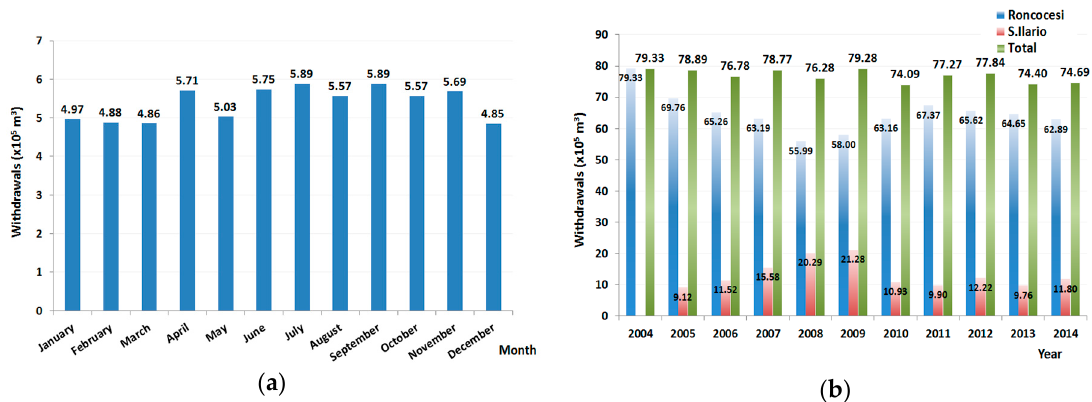
Figure 2. ( a ) Monthly trend of withdrawals from the Roncocesi well field in 2013; ( b ) Annual volumes of groundwater extraction from the Roncocesi well field, with the contribution of S. Ilario Nuovo (2004–2015).